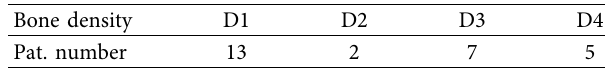
Table 1: Bone density distribution of osseointegrated failure patients.